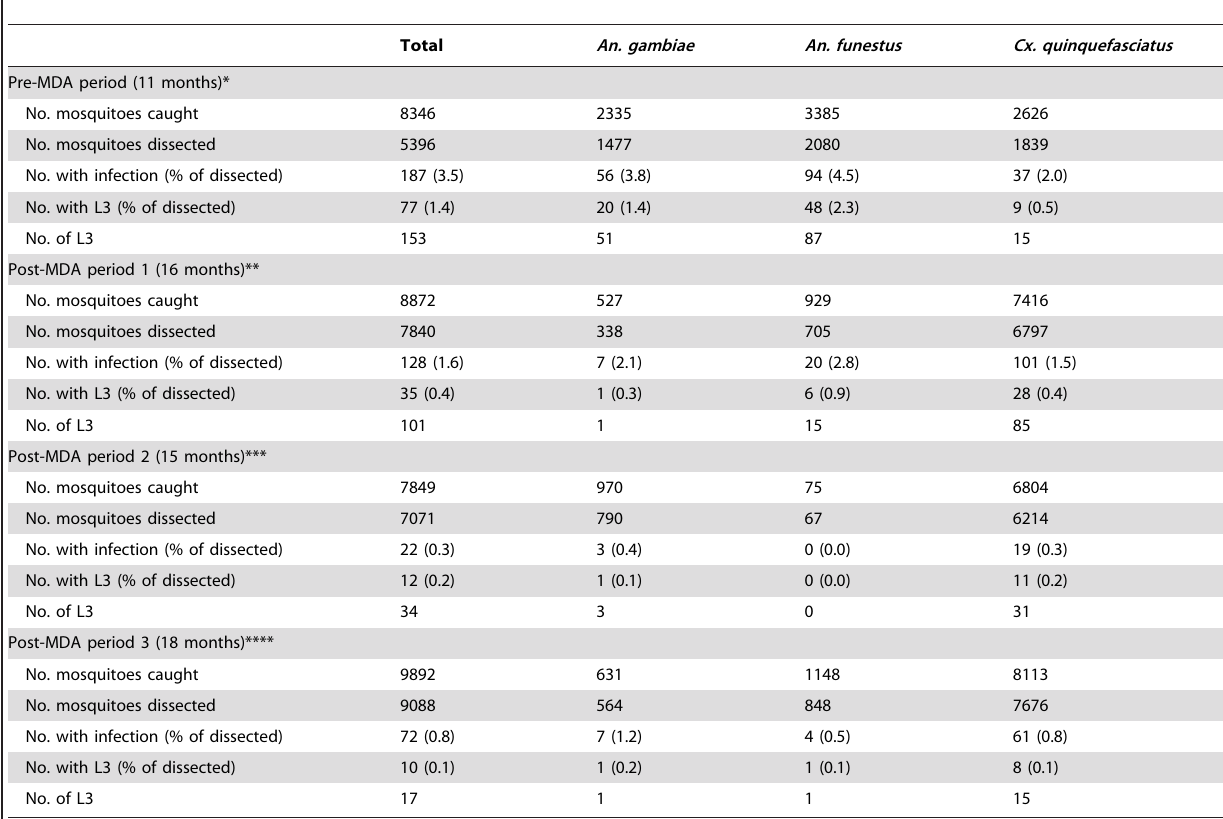
Table 2. Vector mosquito catches from the 50 collection houses in Kirare village, and the results of dissections, during the pre- MDA period and the three post-MDA periods.